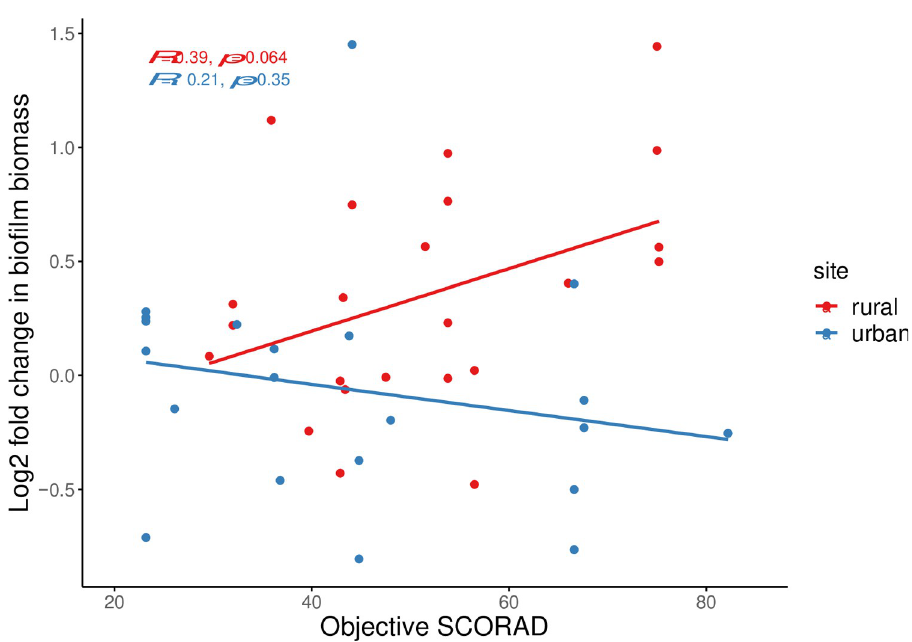
Fig 6. Pearson’s correlation between objective SCORAD and the log fold change of biofilm biomass in co-biofilm cultures of CoNS and S . aureus from mono-species S . aureus biofilms in rural and urban cases.